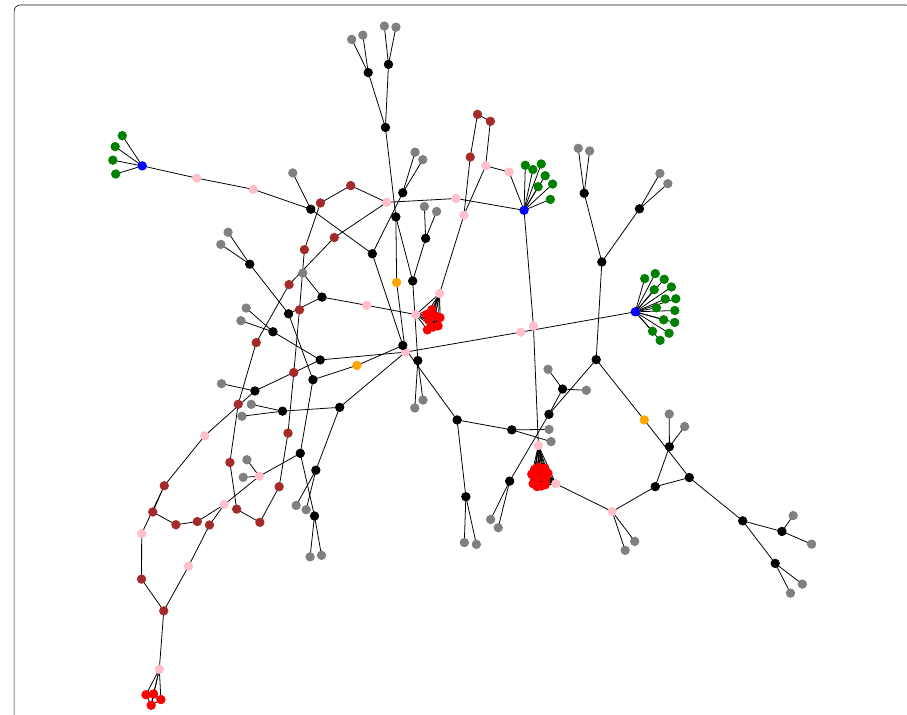
Fig. 6 Target network. Three sets of the four network topologies are randomly connected. Aside from tree graphs, the sizes of each graph are 5, 10, and 15